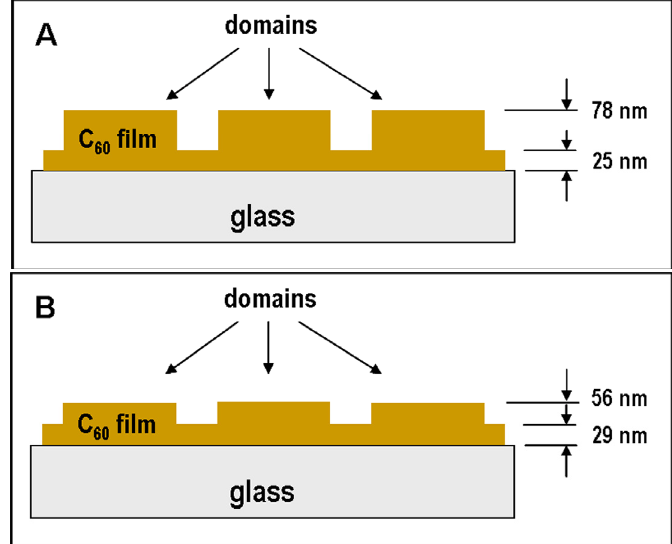
Figure 2. Height of the prominences and the grooves of the micropatterned fresh ( A ) and aged ( B ) C 60